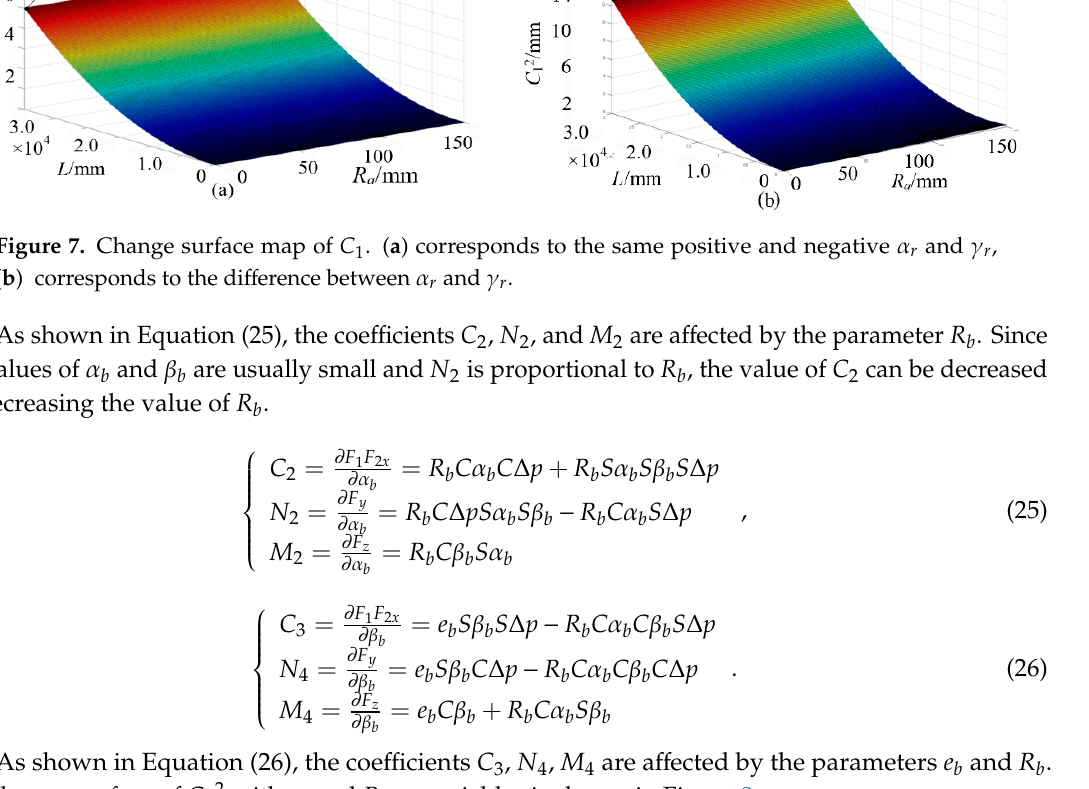
Figure 7. Change surface map of C 1 . ( a ) corresponds to the same positive and negative α r and γ r , ( b ) corresponds to the difference between α r and γ r .